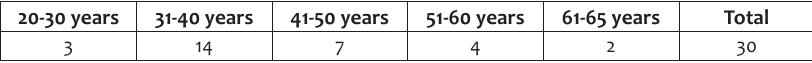
Table 3: Teachers’ ages, teaching experience, and institutions of training 20-30